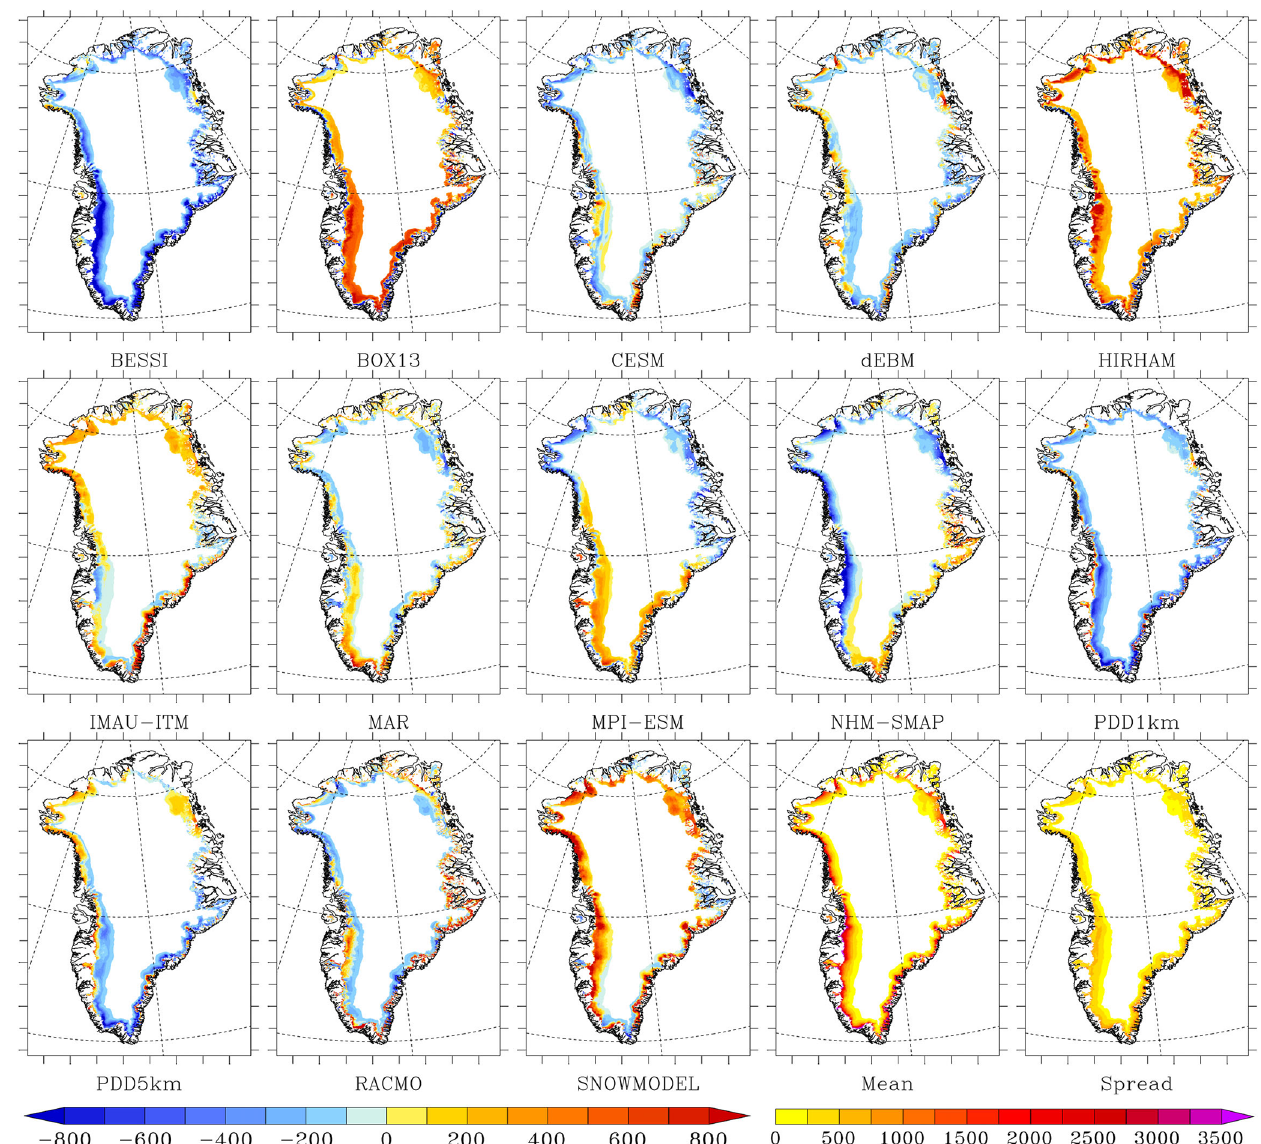
Figure 3. Same as Fig. 2 but for the modelled runoff. The ensemble mean and model spread around the mean are also shown in mmw.e.yr − 1 in the two last plots. Finally it is important to note that only the area where the runoff of the ensemble mean is higher than 100mmw.e.yr − 1 is shown